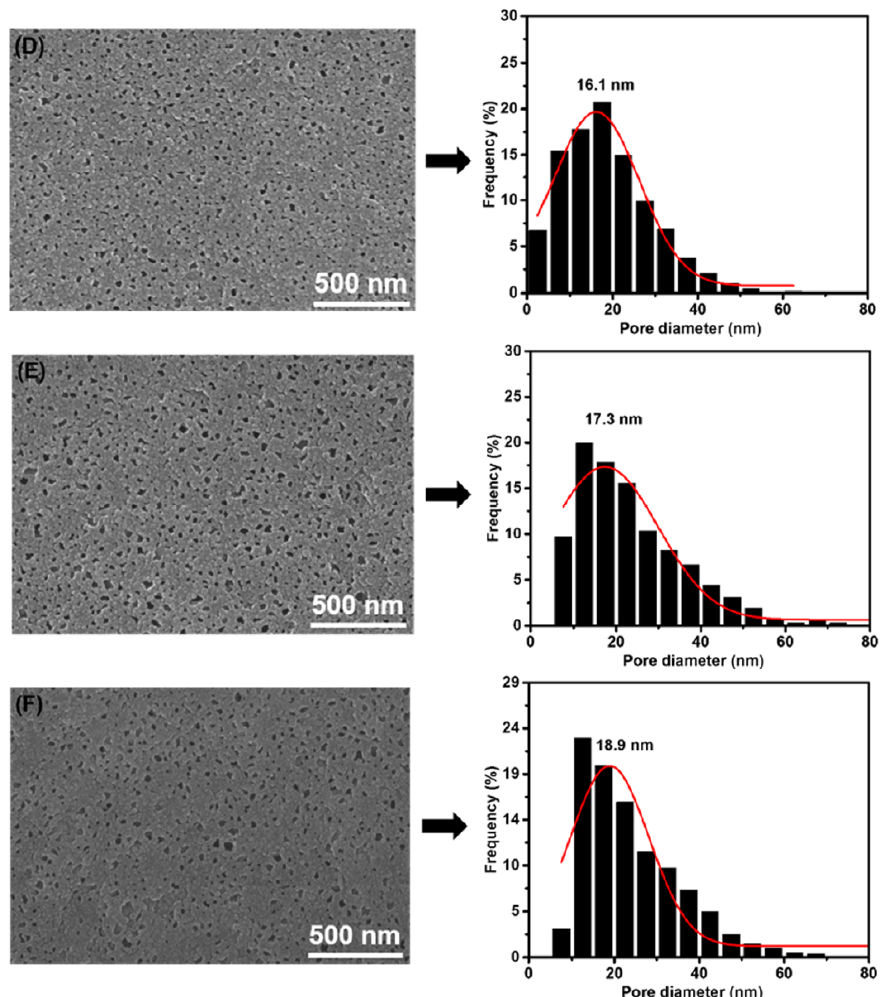
Figure 3. SEM image and porosity of the membranes with different PTS loading: ( A ) TFC membrane; ( B ) TFN 0.1 membrane; ( C ) TFN 0.2 membrane; ( D ) TFN 0.3 membrane; ( E ) TFN 0.4 membrane; ( F ) TFN 0.5